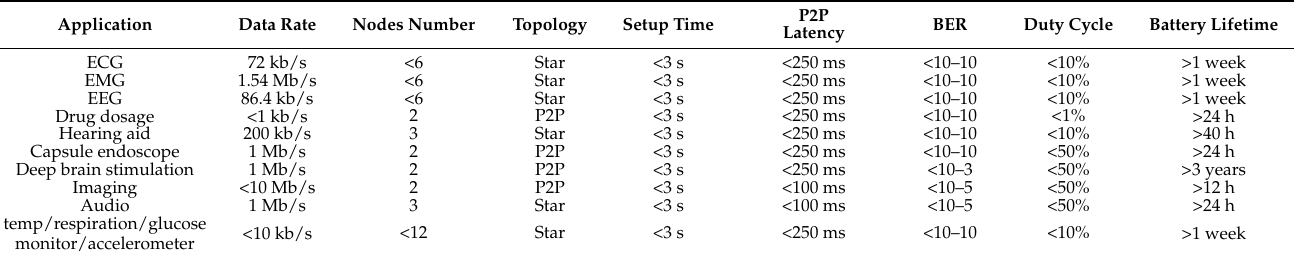
Table 3. Technical requirements of BAN applications.